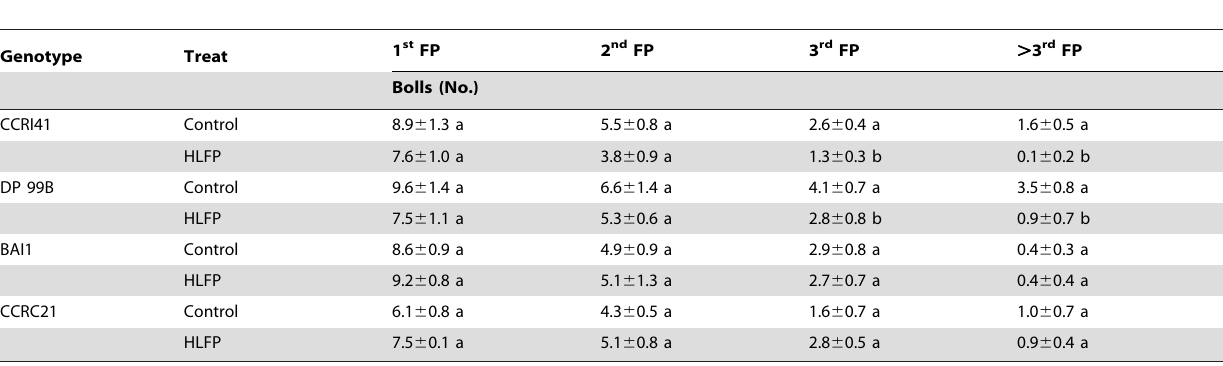
Table 6. Effects of mechanical stress caused by hanging labels from the petioles (HLFP) of every white flower in the field on the number of bolls retention on different fruiting positions (FP) in four cotton genotypes.